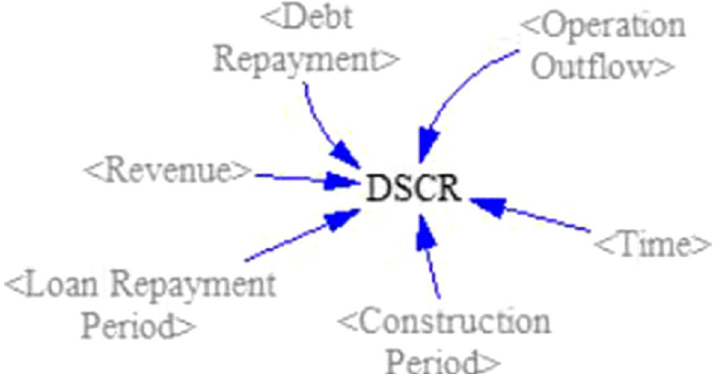
Fig. 7 Stock and flow diagram for the